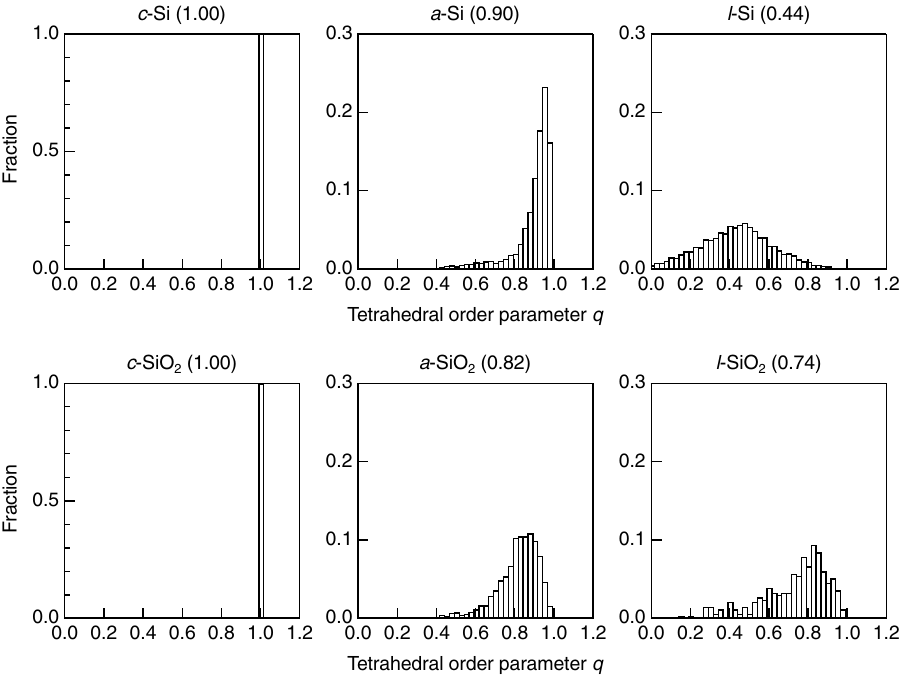
Figure 7. SiSi 4 tetrahedral order parameter q for a series of silicon and silica. Average q values are given in round brackets. The SiSi 4 q parameter of a -SiO 2 remains almost the same in densified glass 2 . The SiO 4 q parameters for c -, a -, and l -SiO 2 are shown in Fig. S4. It is confirmed that the symmetry of SiO 4 in a -SiO 2 is better than that in a -Si, and SiO 4 in l -SiO 2 is more